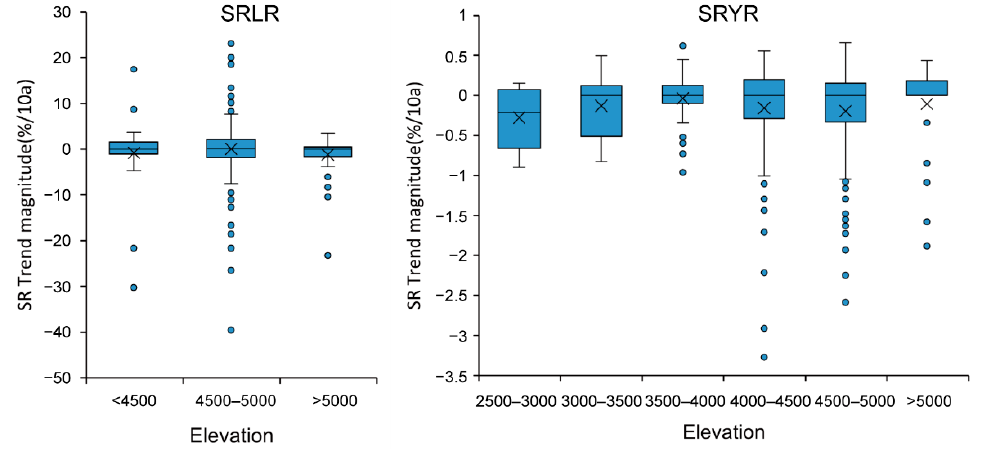
Figure 6. The trend of SR propensity of SRLR and SRYR with altitude.